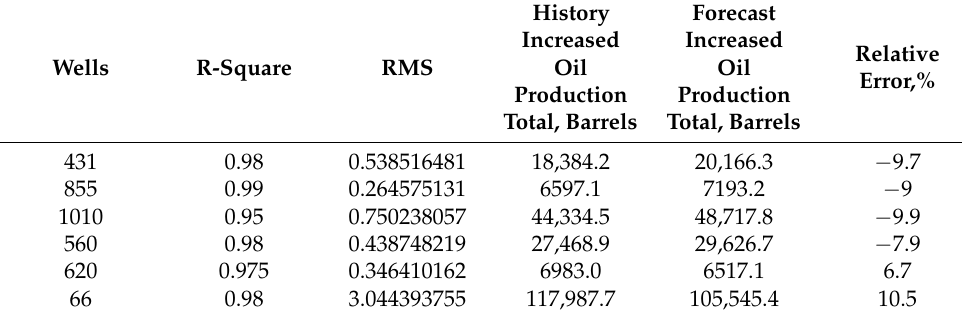
Table 5. Statistical measures of the proposed forecasting